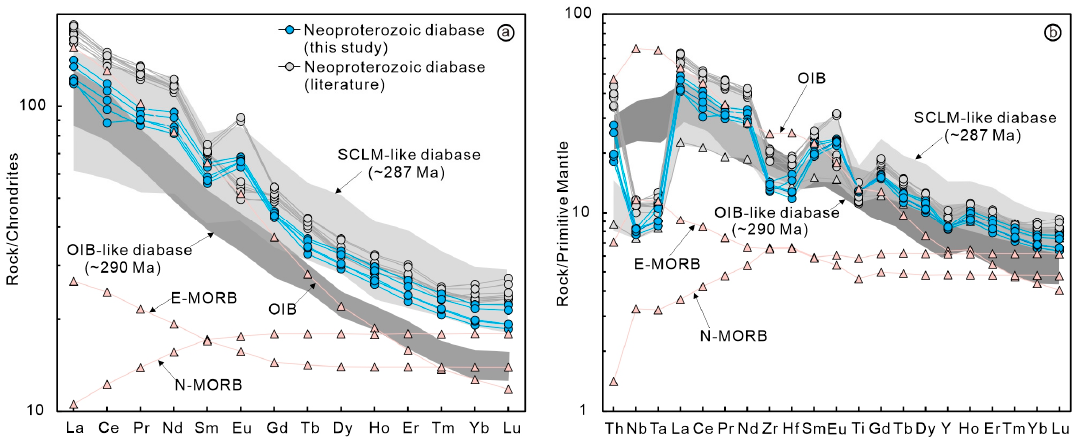
Figure 6. Chondrite-normalized REE patterns ( a ) and primitive mantle-normalized multiple-trace- element diagrams ( b ) for Aksu Neoproterozoic diabase dykes. Data sources: N-MORB; E-MORB; OIB values are from [27,45]; and 287 Ma sub-continental lithospheric mantle (SCLM)-like diabase and 290 Ma ocean island-arc basalt (OIB)-like diabase in the Aksu area are from [38]. Literature data are compiled in Supplementary Table